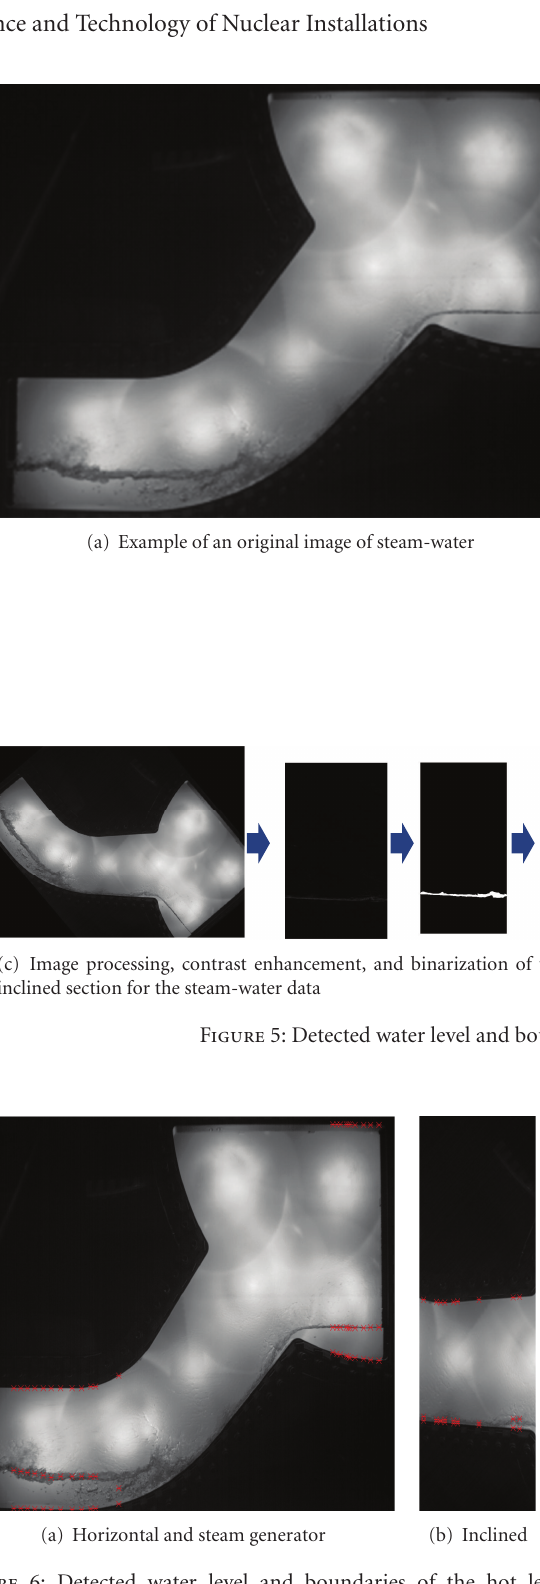
Figure 6: Detected water level and boundaries of the hot leg channel